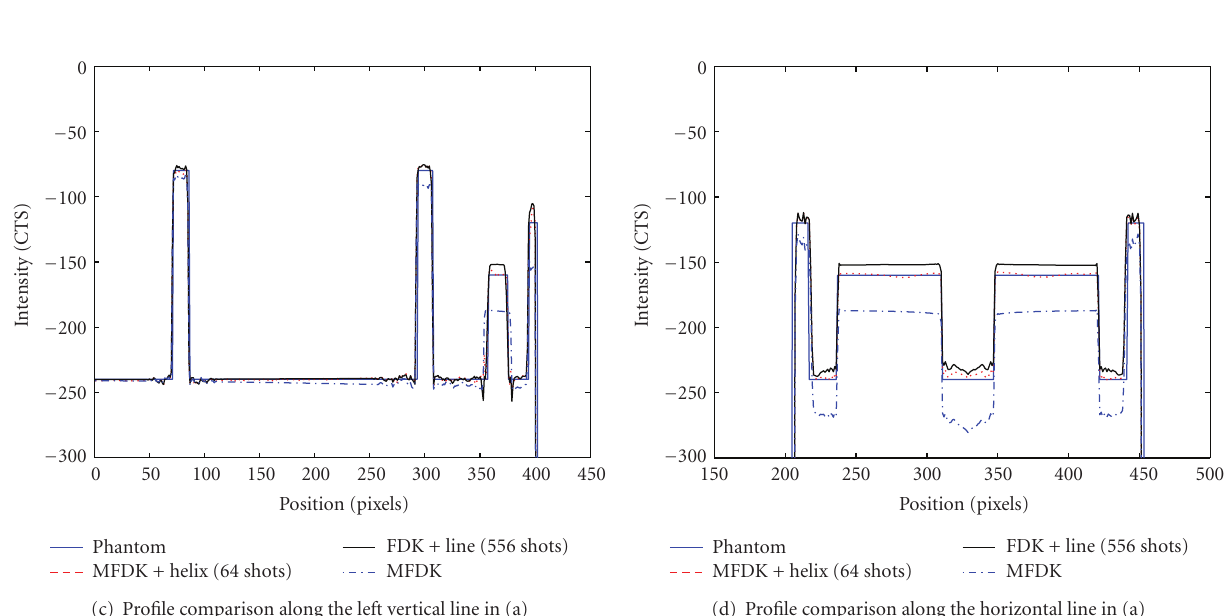
(a) Phantom image with three profile lines (b) Profile comparison along the middle vertical line in (a)